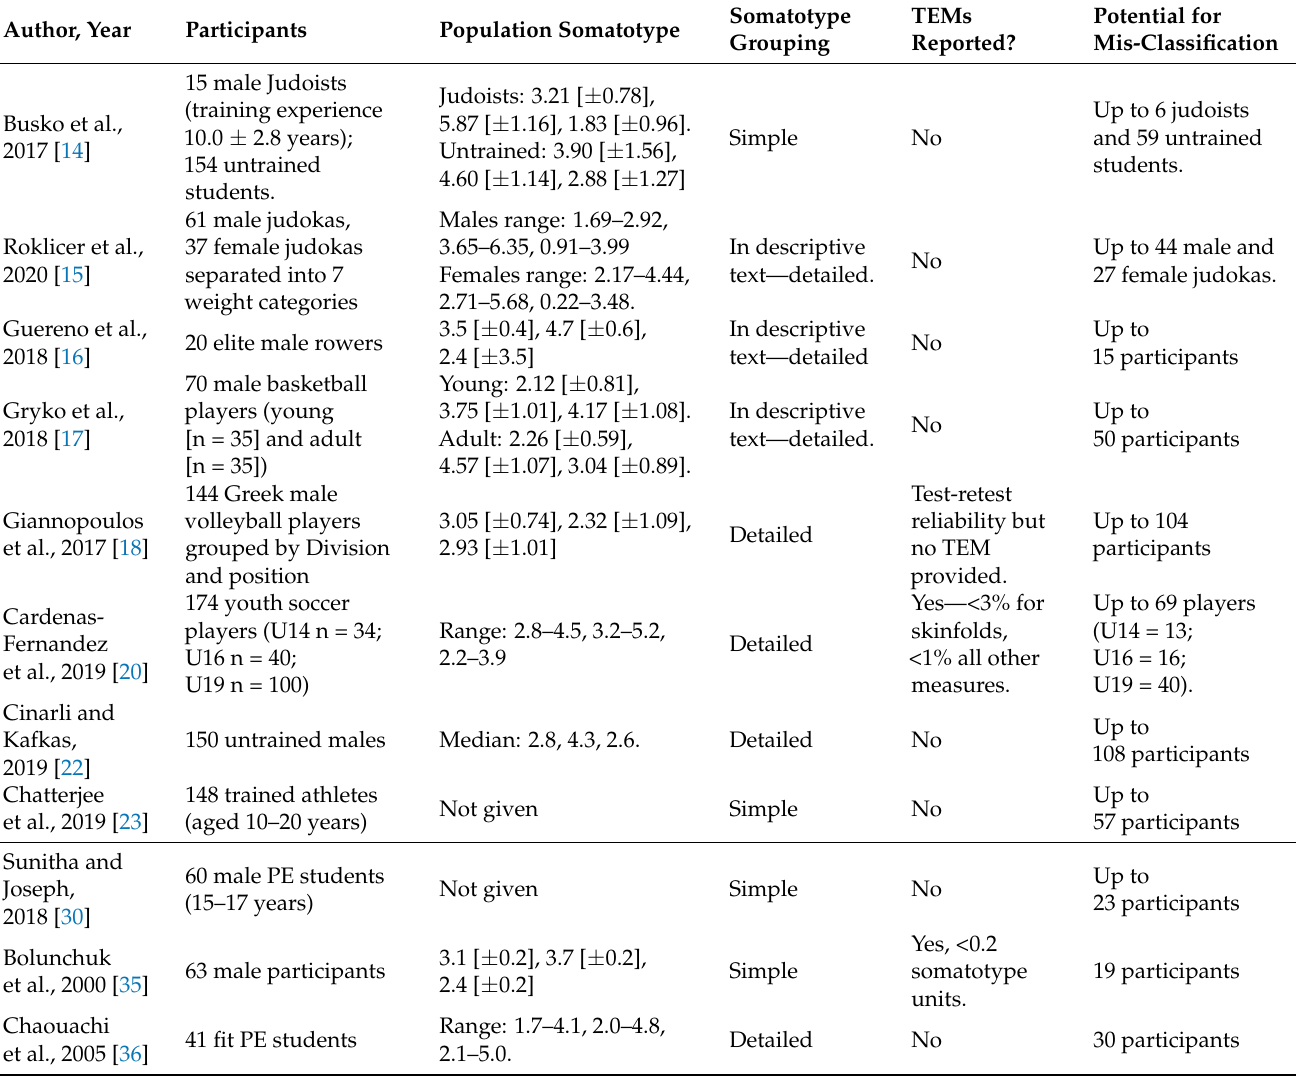
Table 2. Summary of reviewed somatotype literature using grouping to determine differences in outcome